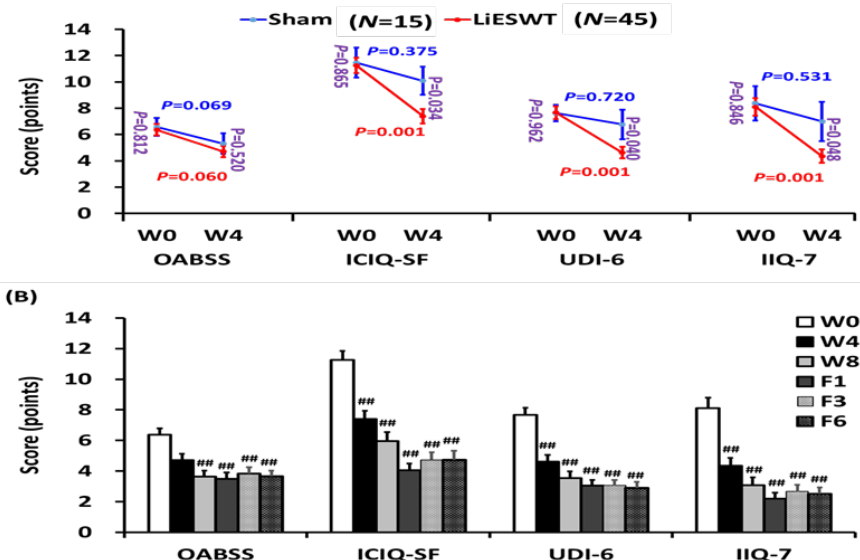
Figure 3. Changes in stress urinary incontinence (SUI) symptoms and validated standardized questionnaire scores after the LiESWT treatment. ( A ) The validated standardized questionnaire scores included the Overactive Bladder Symptom Score (OABSS), International Consultation on Incontinence Questionnaire Short Form (ICIQ-SF), Urogenital Distress Inventory (UDI-6) Short Form, and Incontinence Impact Questionnaire-7 (IIQ-7) score at week 4 (W4) in the sham group ( N = 15) and the LiESWT-treated group ( N = 45). The blue font or red font denotes the p -value before and after 4 weeks treatment in the sham group or in the LiESWT-treated group, respectively. The purple font indicates the p -value between the sham group and the LiESWT-treated group at the baseline (W0) and W4. Values are the means ± SE. ( B ) The OABSS, ICIQ-SF, UDI-6, and IIQ-7 questionnaire scores analyzed at W4, 8 weeks (W8), 1-month follow-up (F1), 3-month follow-up (F3), and 6-month follow-up (F6). Values are the means ± SE. N = 45. ## p < 0.01 compared to the